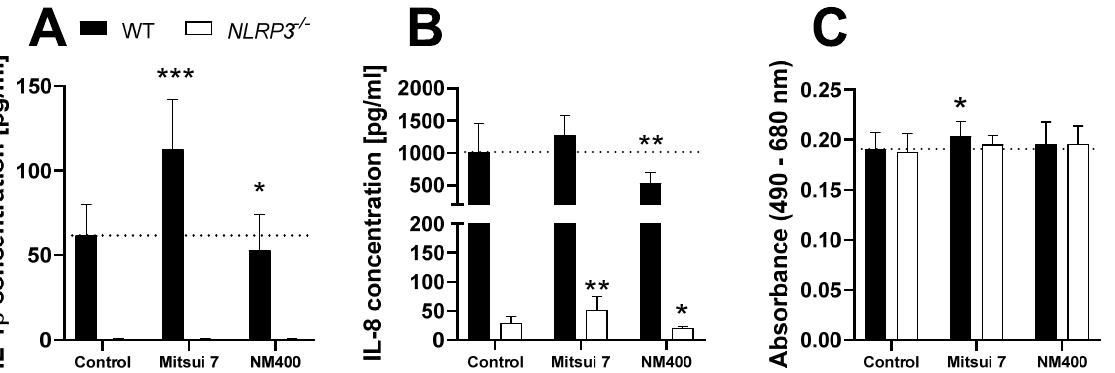
Figure 5. Release of IL-1 β ( A ) and IL-8 ( B ), as well as LDH activity ( C ) in the supernatant of PMA- differentiated THP-1 WT (full bars) or NLRP3 − / − (open bars) cells after 24 h treatment with 50 µg/cm 2 of two different MWCNTs. Cytokine data is depicted as relative values compared to the WT control, LDH data is depicted as relative values compared to the respective control. Mean ± SD of N = 4, * p < 0.05, ** p < 0.01, and *** p < 0.001 compared to the respective control.